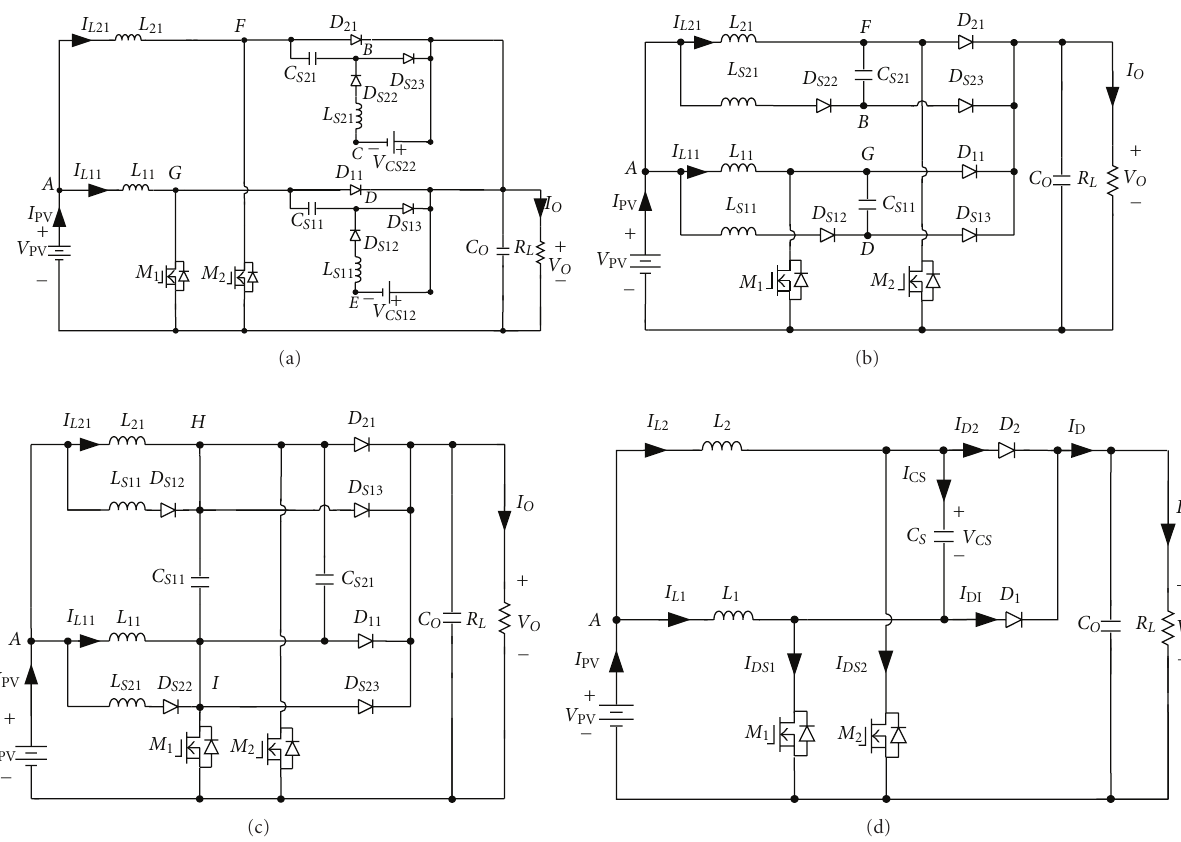
Figure 11: Derivation of the proposed battery charger with a single-capacitor turn-o ff